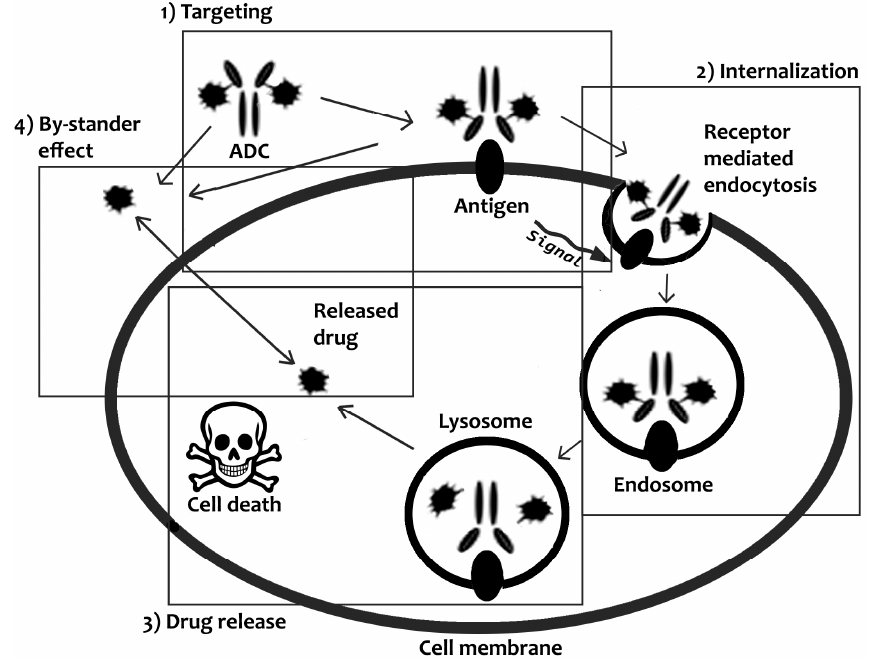
Figure 2. Schematic illustration of the mechanism of drug delivery and release mediated by